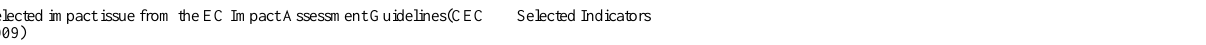
Table 1. Selected impact issues from the EC Impact Assessment Guidelines (CEC 2009) and respective indicators selected for this